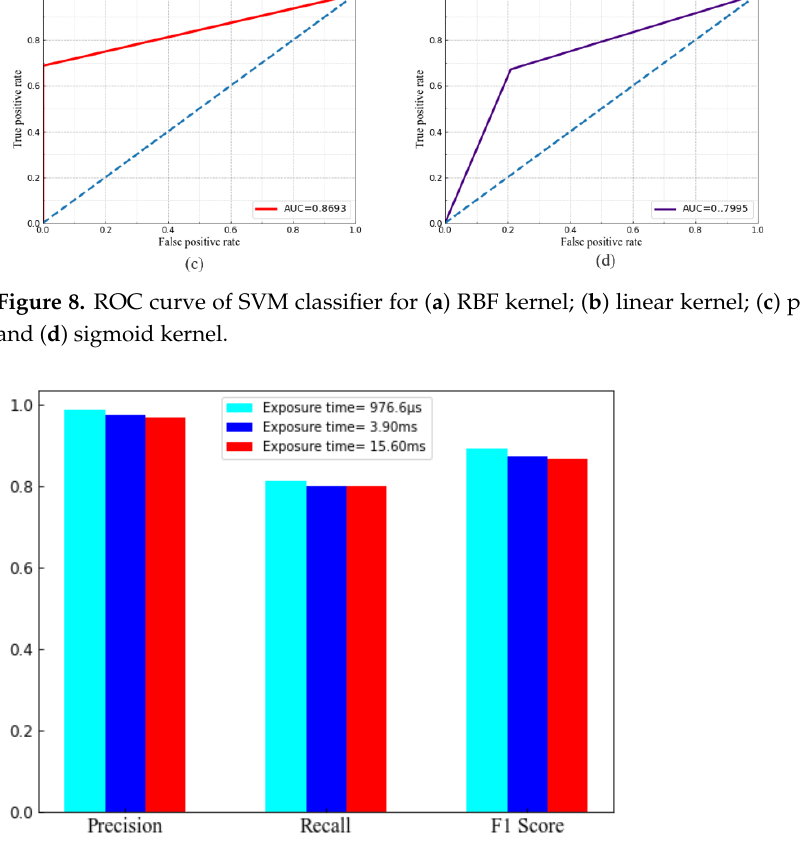
Figure 9. Comparison among precision, recall, F1 score varying exposure time ( T e ). Table 3. Classifier performance (accuracy and AUC) analysis with a different no. of LEDs. No. of Data Transmitting